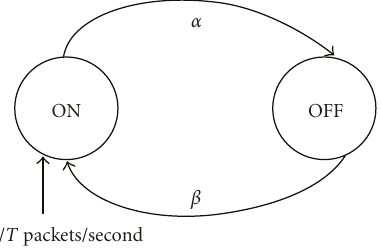
Figure 5: Voice over IP (VoIP) Model.